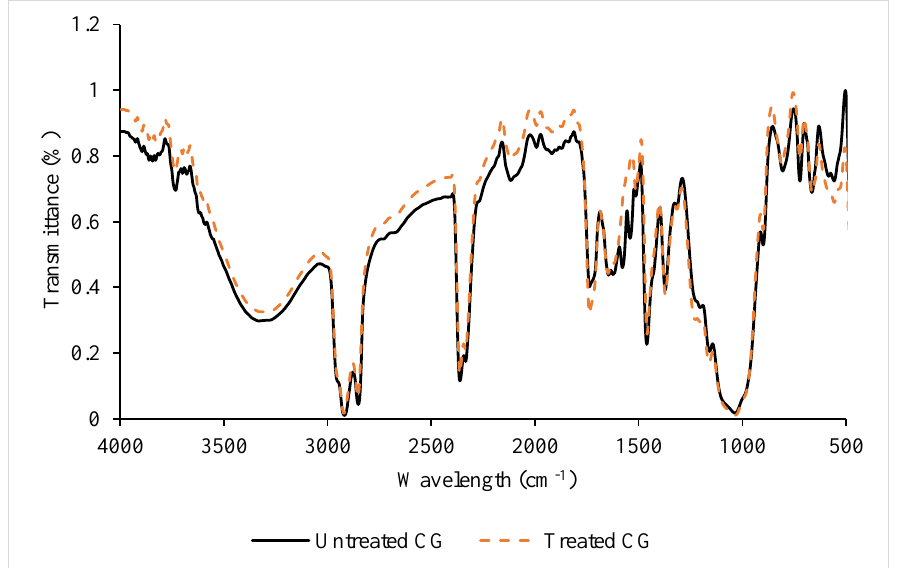
Figure 4. ATR-FTIR spectra of untreated and treated cogon grass after sorption. Treated cogon grass was heated at 120 °C for 45 min.